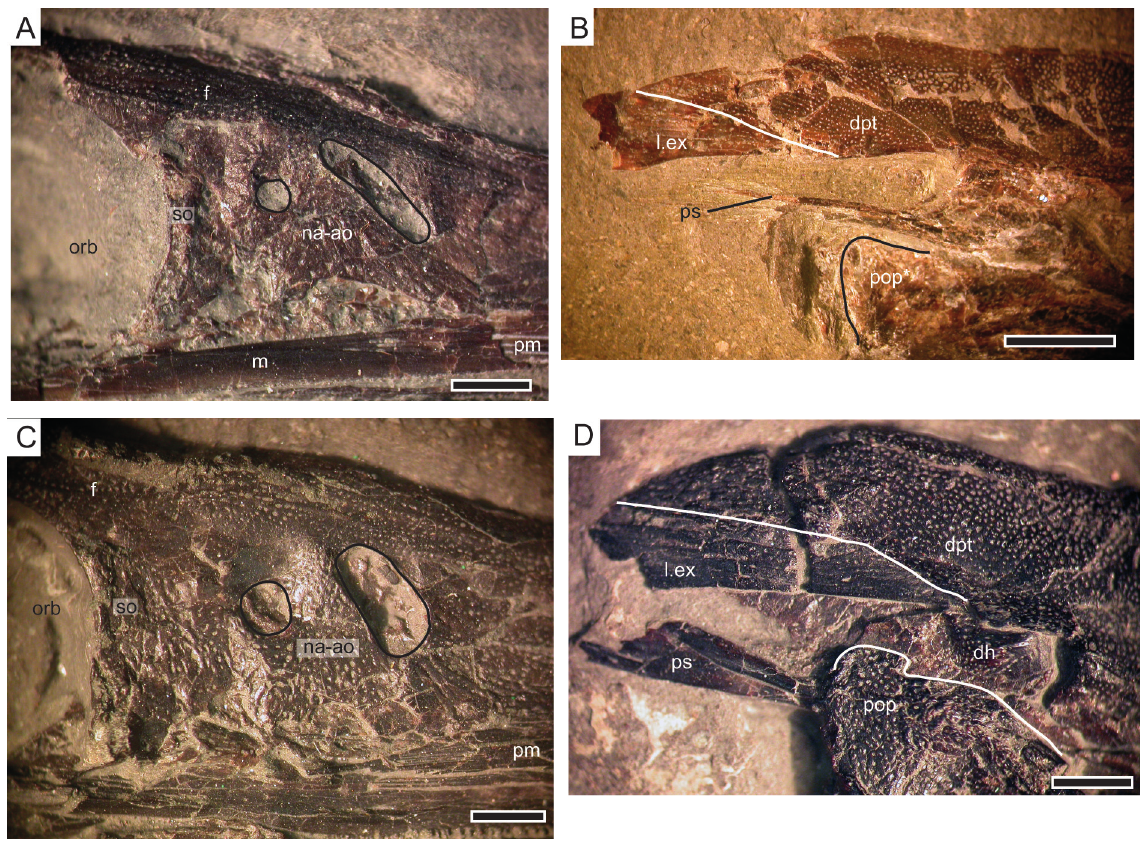
Fig. 5. Characters distinguishing Saurorhynchus acutus (Agassiz, 1844) and S. hauffi sp. nov. A . S. acutus , narial region (SMNS 56923). B . S. acutus , lateral extrascapular-dermopterotic contact (SMNS 57039). C . S. hauffi sp. nov., narial region (SMNS 51888). D . S. hauffi sp. nov., lateral extrascapular-dermopterotic contact (SMNS 53980, mirrored). Abbreviations: dpt = dermopterotic; dh = dermohyal; f = frontal; l.ex = lateral extrascapular; m = maxilla; na-ao = nasaloantorbital; orb = orbit; pm = rostropremaxilla; pop = preopercle; pop* = damaged preopercle; ps = parasphenoid; so = supraorbital. Scale bars: A, C–D = 2 mm; B = 5